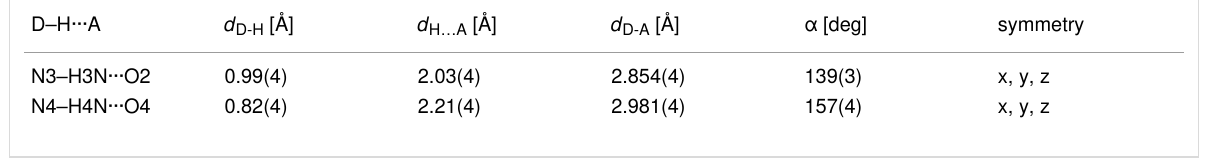
Table 2: Intramolecular hydrogen bonds in 2a at room temperature, which involve the NH groups with one keto oxygen (O2) and one sulfinamide oxygen (O4). Atom numbering as in Figure 1. The asymmetry of such interactions reflects the intrinsic asymmetry of the solid-state conformer.